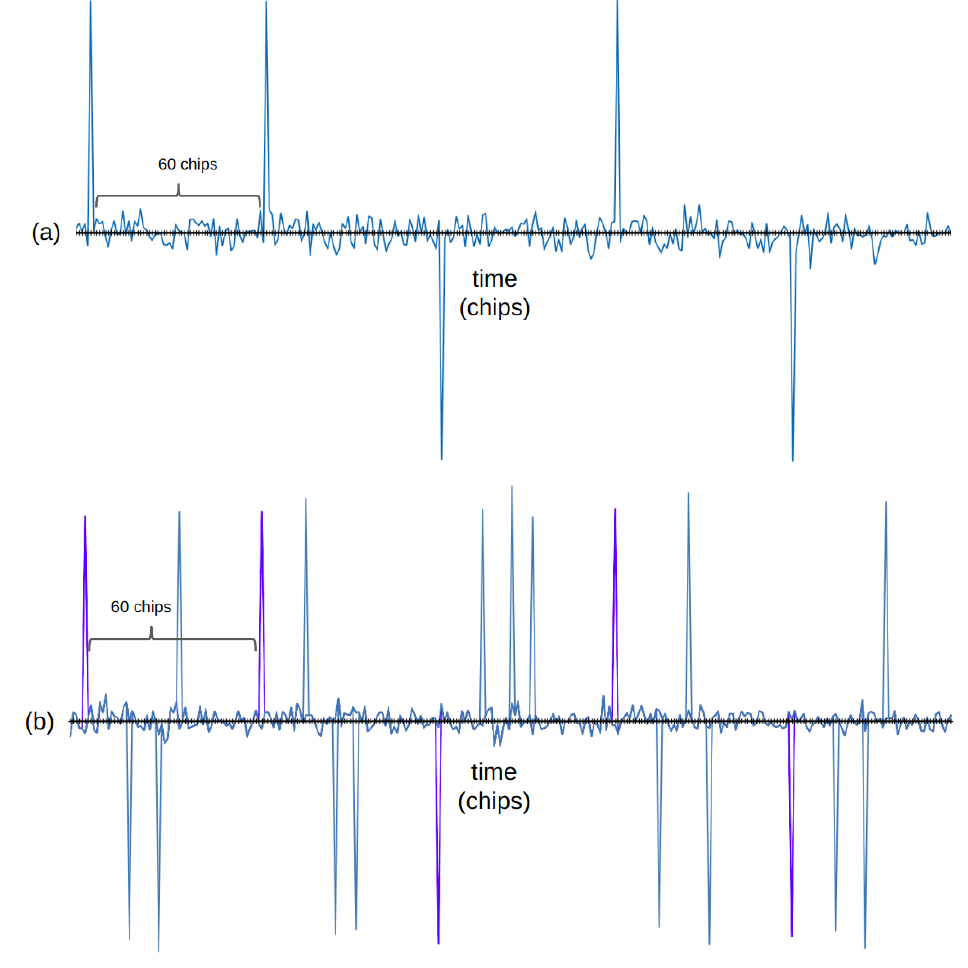
Figure 5. In ( a ), the signal received by the satellite from one transmitter. In ( b ), the signal received by the satellite from four transmitters; signals are still decodable because of the offset of chips between the different terminals. Figure adapted from